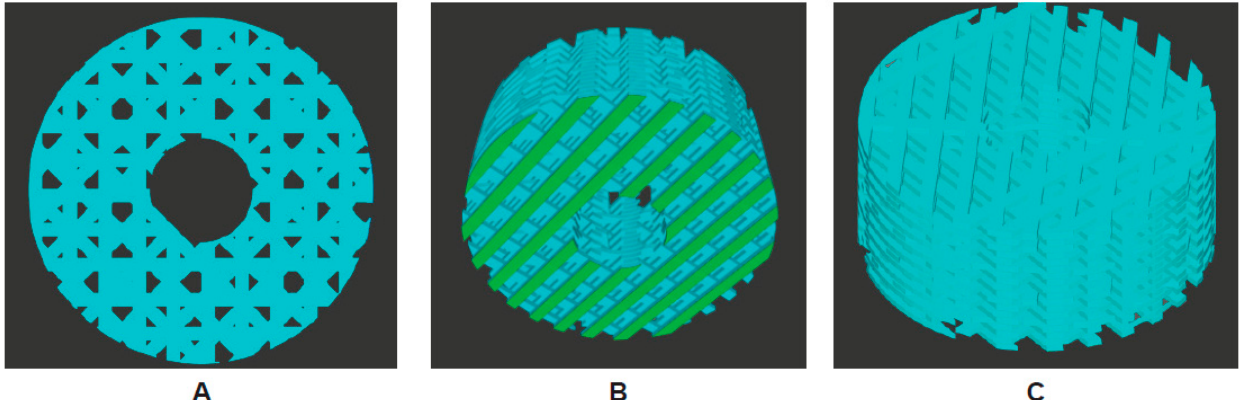
Figure 1. Biofabrication design. Slicer software showing ( A ) front, ( B ) bottom, and ( C ) oblique views of the printed scaffold.